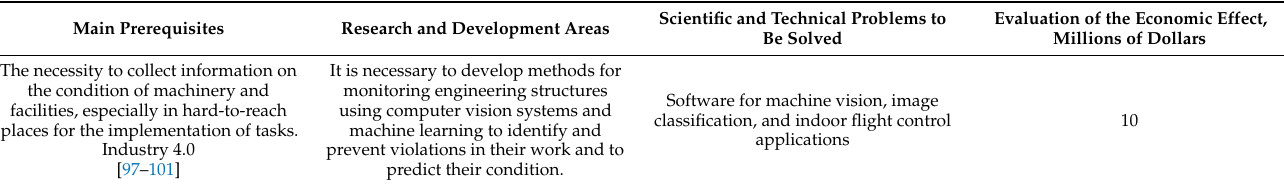
Table A7. IUAVT use for monitoring of technical and engineering structures.